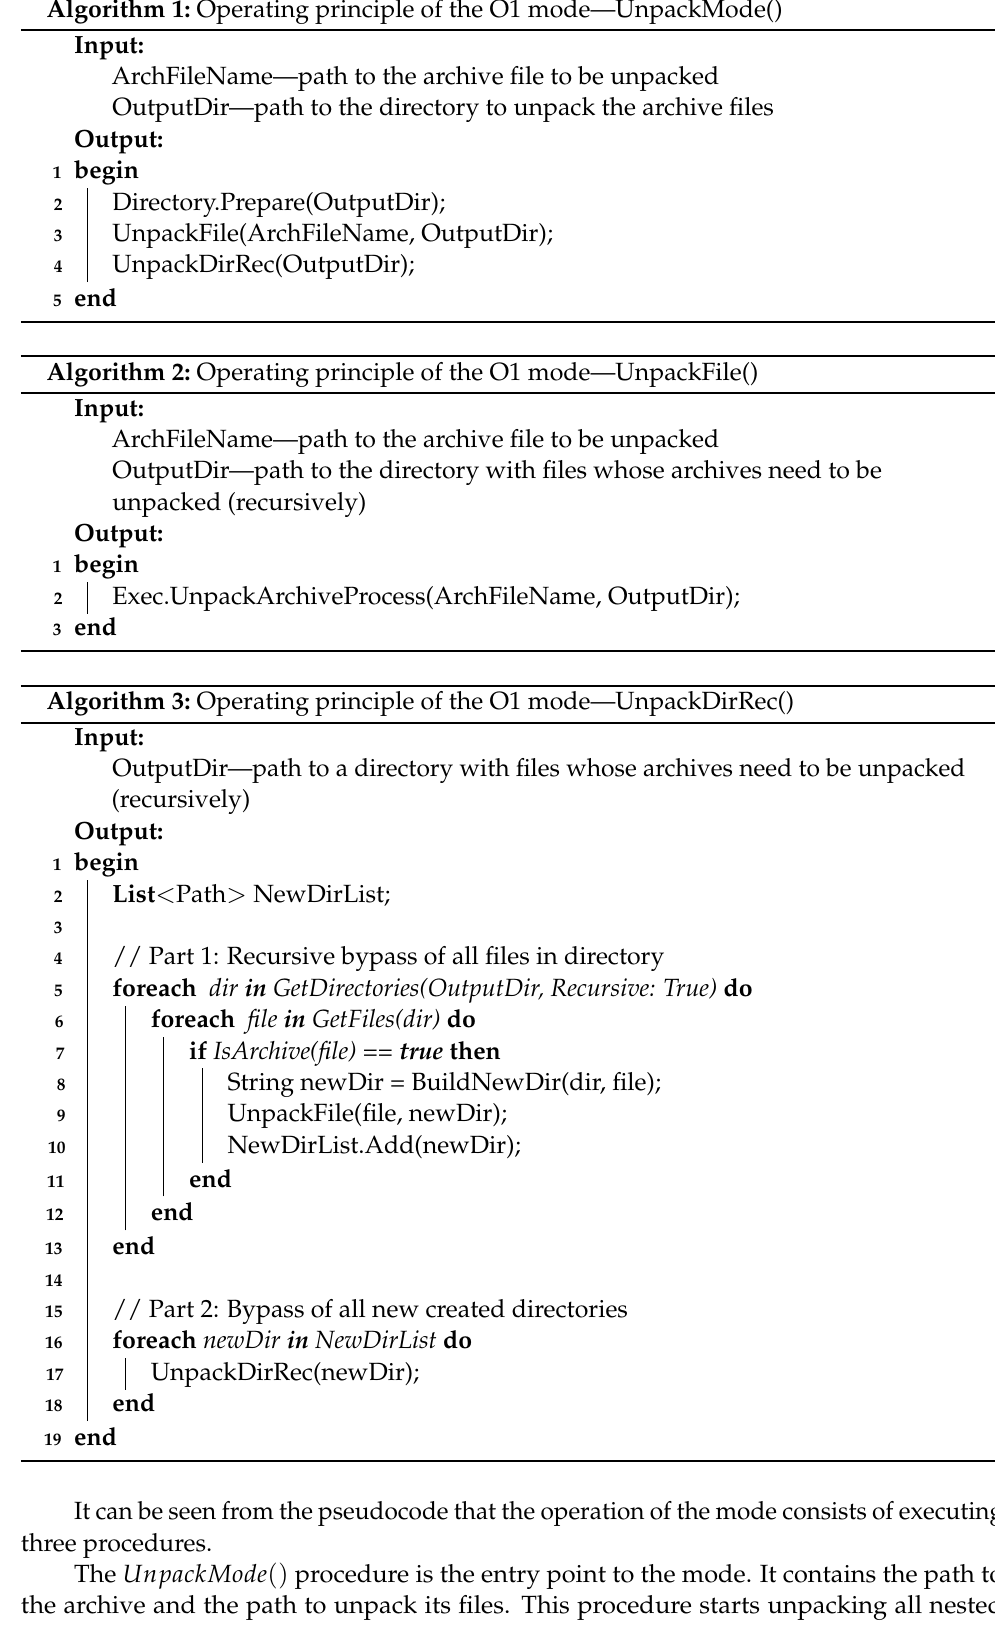
Algorithm 1: Operating principle of the O1 mode—UnpackMode()